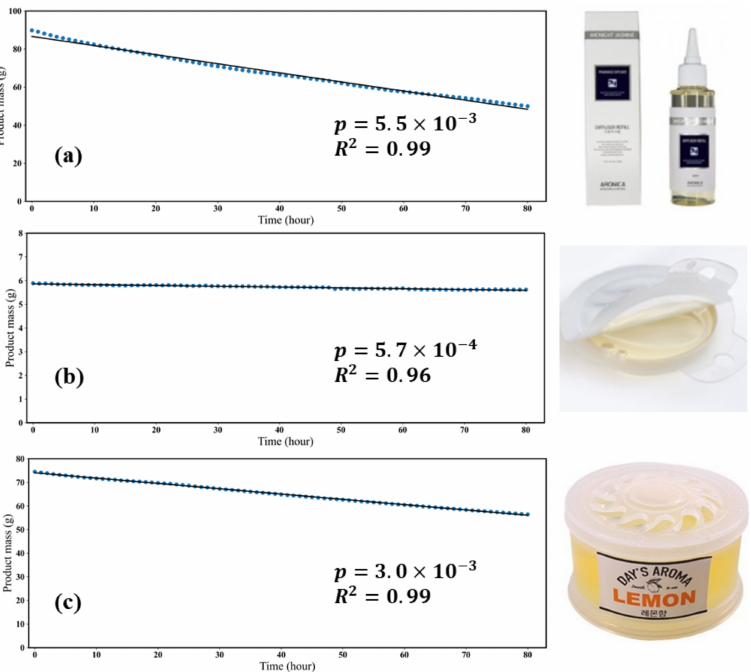
Figure 1. The weight measurement results for three products: ( a , b ) liquid type, ( c ) gel type. Table 2. Product mass reduction rate coefficient ν of 20